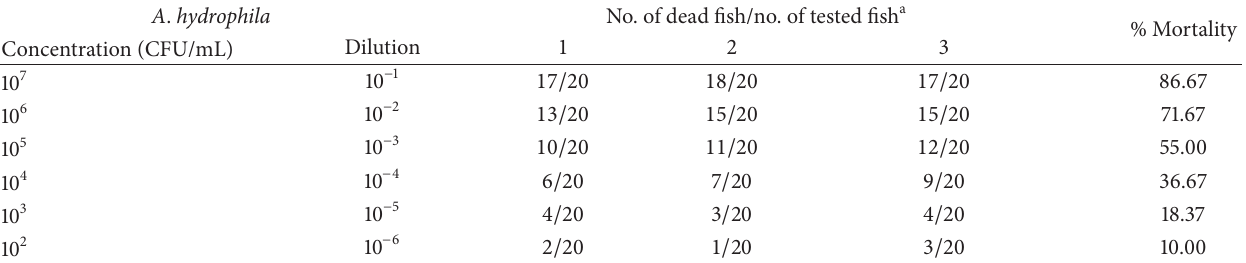
a results from all replicates (replicate 1 to replicate 3).